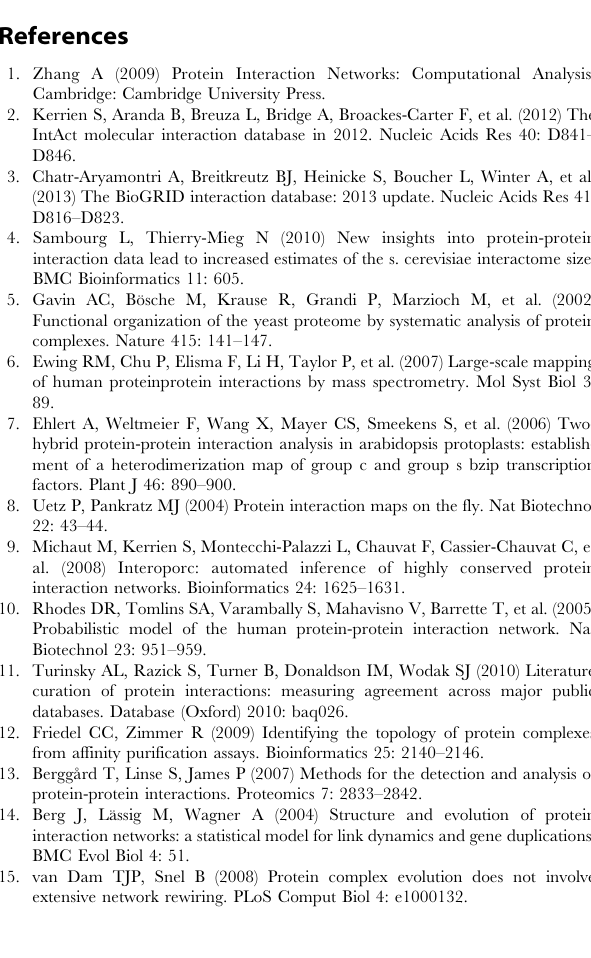
Figure S4 Transfer examples. Examples of transferred interactions which get high and low scores by RFFs including specific feature values for these interactions and the overall feature distribution (the scores are estimated via a cross-validation setting). Figure S5 Protein interaction scores for the transfer of interactions to S. cerevisiae . The average transfer scores for an interaction transfer from M. muscles , H. sapiens , S. pombe , A. thaliana , C. elegans and D. melanogaster to S. cerevisiae using RFFs in a cross-validation setting. Figure S6 Information Gain feature ranking. The feature importance ranking i.e. the ranking of features, is quite similar especially for the most important features, whereas the ranking of the less important feature varies more. Table S1 Data sources . List of data sources used for this